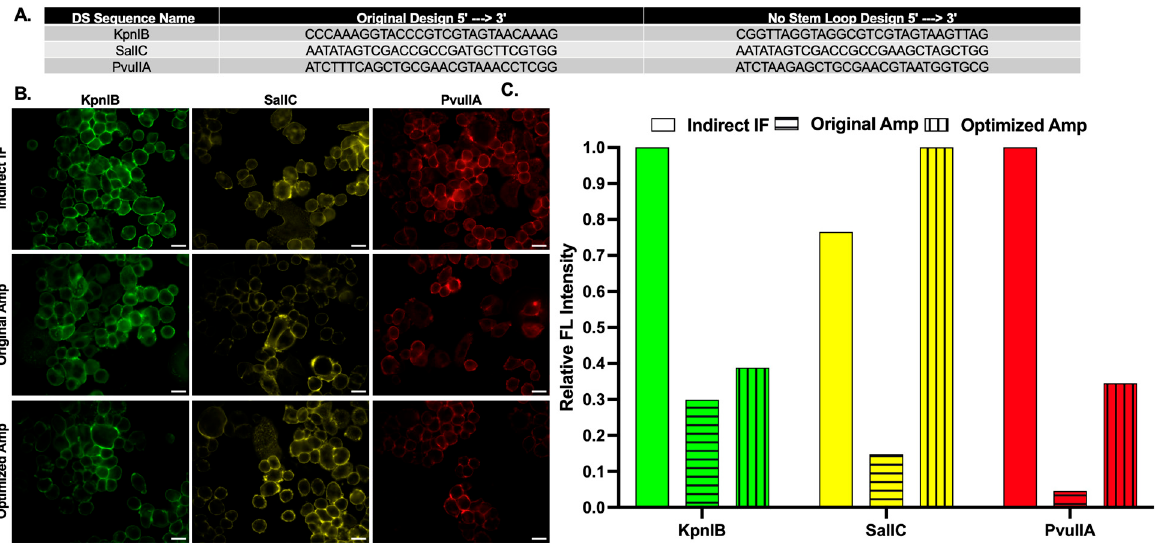
Figure 5. Optimized docking strand (DS) sequence design. ( A ) Three DS were evaluated for secondary structure formation and redesigned to reduce these potential structures. ( B ) Fixed cells were stained for HER2 using conventional indirect IF and HER2 Ab-oligo conjugates containing either the original or optimized KpnIB (green), SalIC (yellow), and PvuIIA (red) DS sequence. All images are set to auto-contrast settings for visualization of HER2-specific staining patterns. ( C ) Relative fluorescence intensity was quantified for each image for antibody staining comparison between indirect IF, the original DS sequence design, and the optimized DS sequence design. Images shown are representative of multiple fields of view and quantification results are reported as a representative average of all images. Scale bar = 50 μ m.